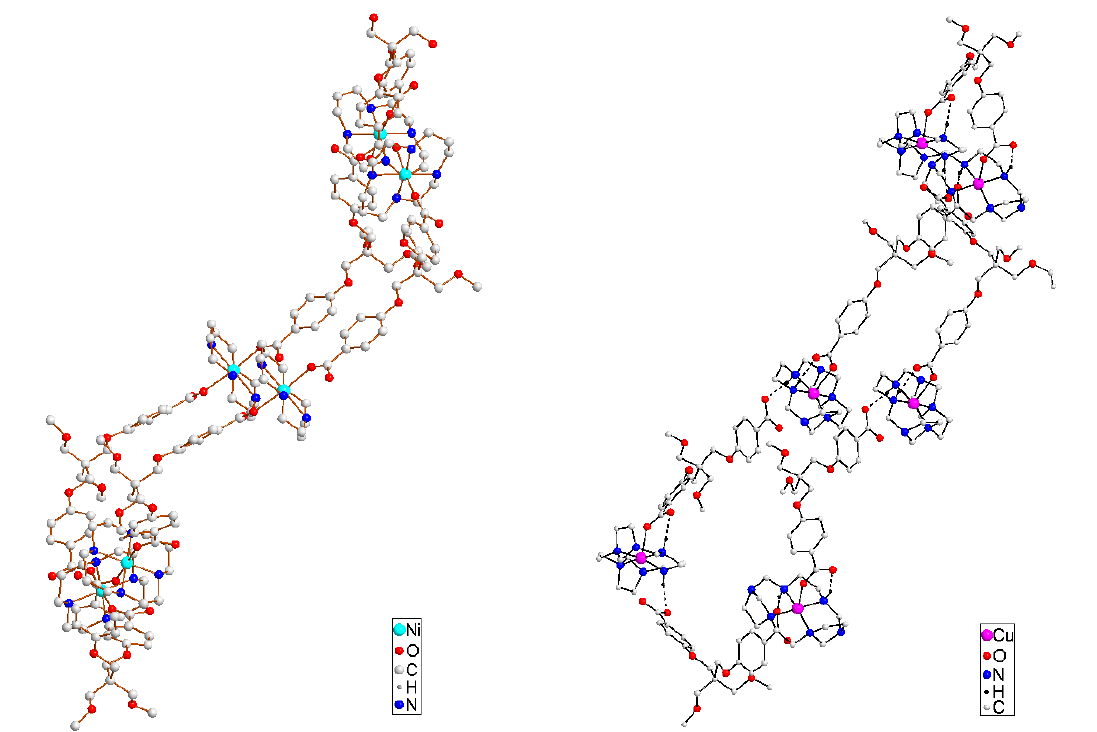
Figure 4. View of the ring built from six macrocyclic complex cations and six TCM 4- units: chair conformation in [Ni(cyclam)] (left) [ 2 ], and twisted conformation in [Cu(CHA)]